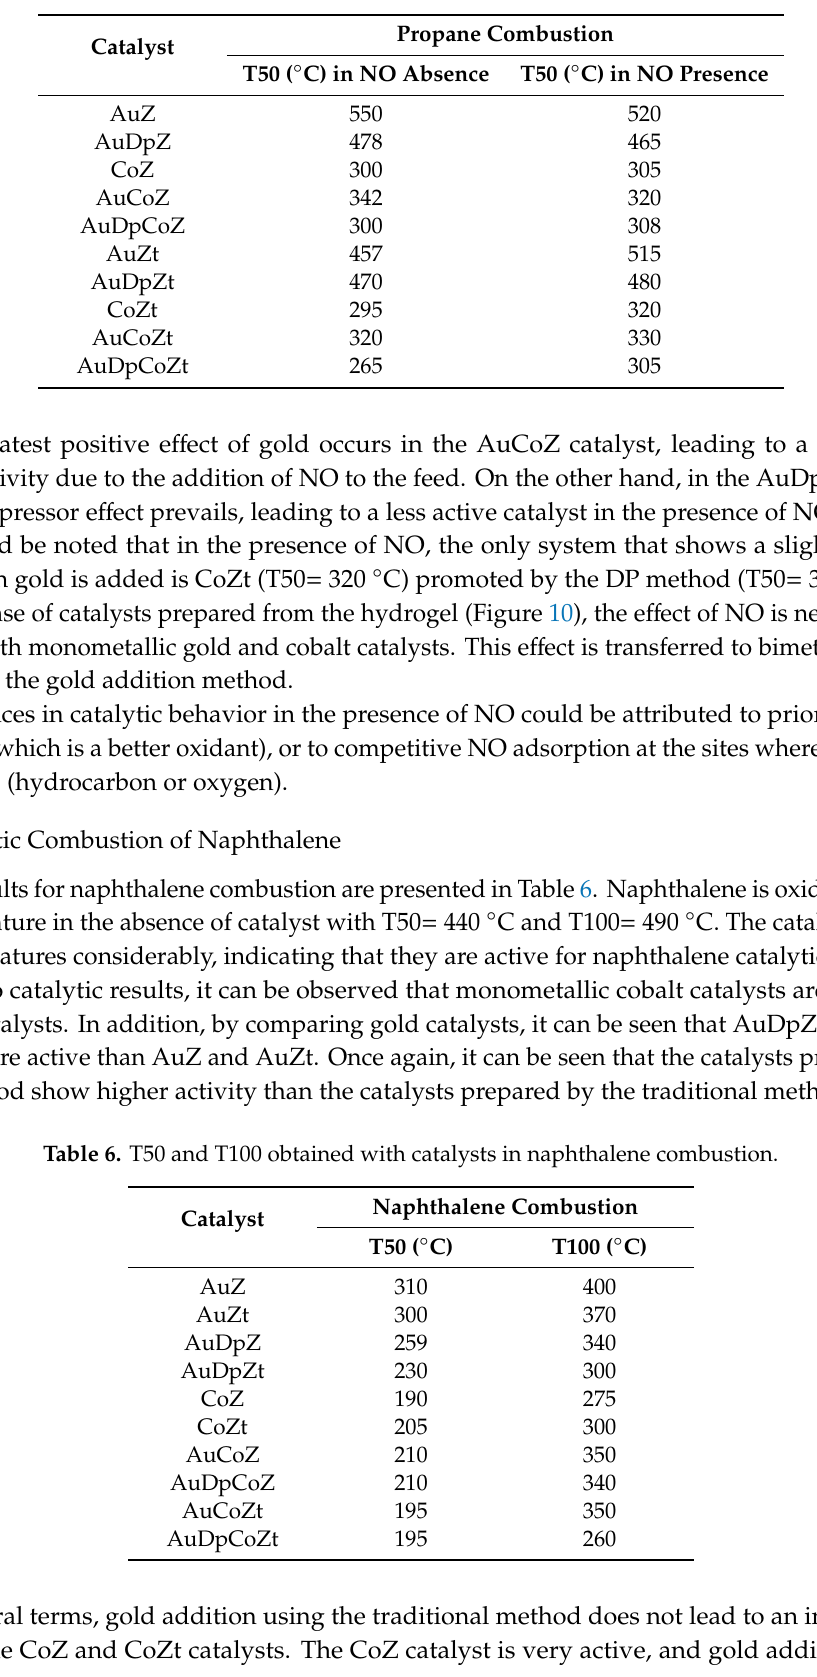
Table 5. T50 obtained with catalysts in propane combustion with and without nitric oxide (NO).